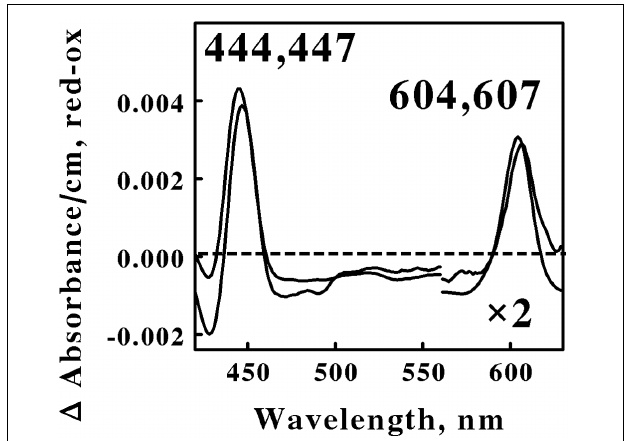
FIGURE 2 | Reduced minus oxidized difference spectra obtained when excess ferrous sulfate was mixed with intact cells of Sulfobacillus thermosulfidooxidans (lower wavelengths) and Alicyclobacillus ferrooxydans (higher wavelengths), representing the Firmicutes. The number of cells present in 8 ml were 6.8 × 10 10 and 4.4 × 10 10 for S. thermosulfidooxidans and A. ferrooxydans , respectively. The absorbance values in the α regions of both spectra were multiplied by 2 to aid in the clarity of